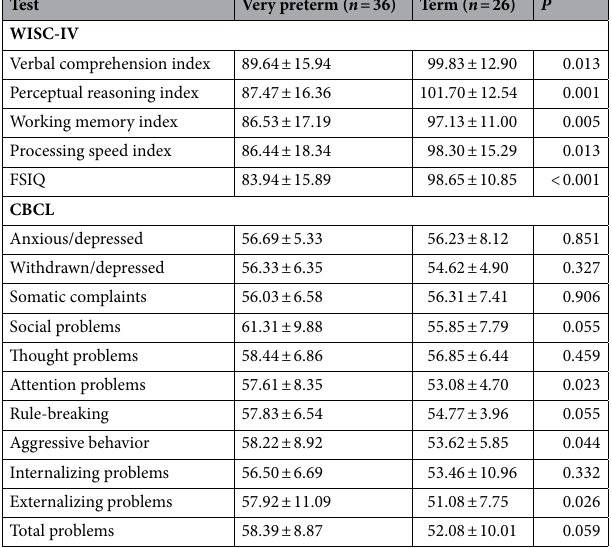
Table 2. Comparison of neurodevelopmental outcomes. Data are shown as mean ± standard deviation. CBCL Child behavior checklist, FSIQ full-scale intelligence quotients, WISC-IV Wechsler Intelligence Scale for Children, Fourth Edition.